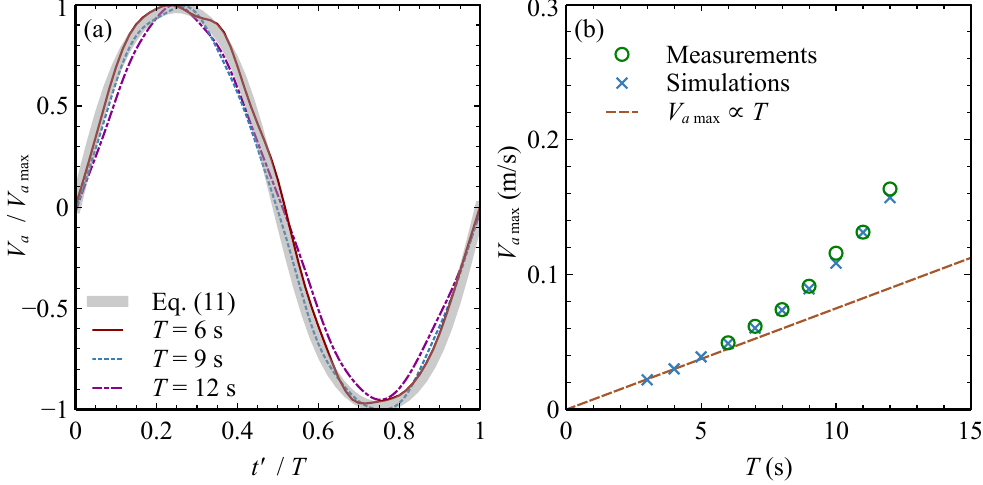
Figure 4. ( a ) Measured time series of flow velocity ( V a ) for T = 6, 9, and 12 s and R 1 = 100, 300, and 600 rpm with U-tube mode. ( b ) The maximum velocity V a max against R 1 from the experiments and